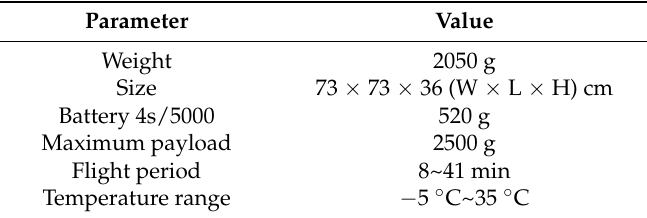
Table 1. The parameters for the UAV of ARF-MikroKopter.